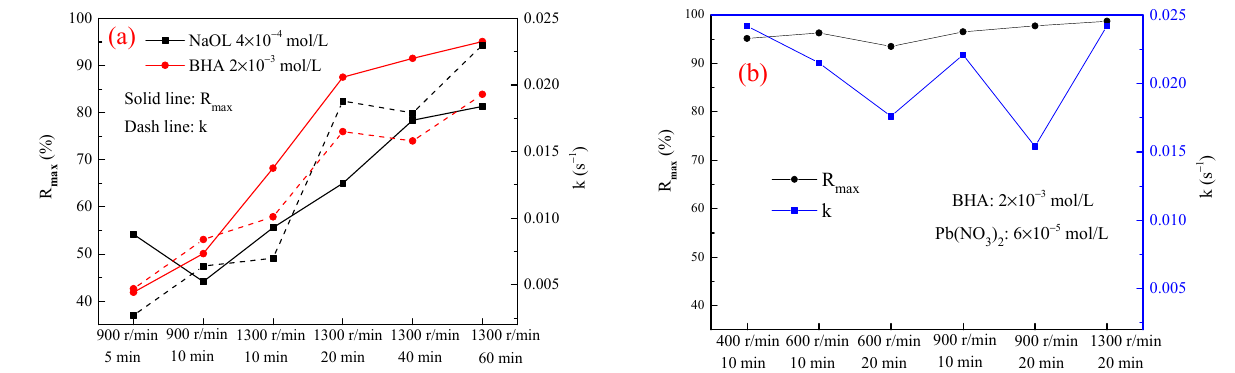
Figure 11. Fitting results of − 37 + 10 μ m cassiterite flotation rate experiments in the presence of NaOL and BHA ( a ) and Pb 2+ + BHA ( b ) under different stirring conditions.